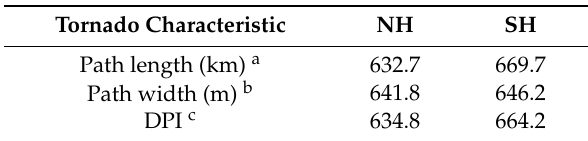
Table 10. Mean ranks used in the Mann-Whitney tests for the north half (NH) and south half (SH). Results of the Mann-Whitney tests are located below the table.